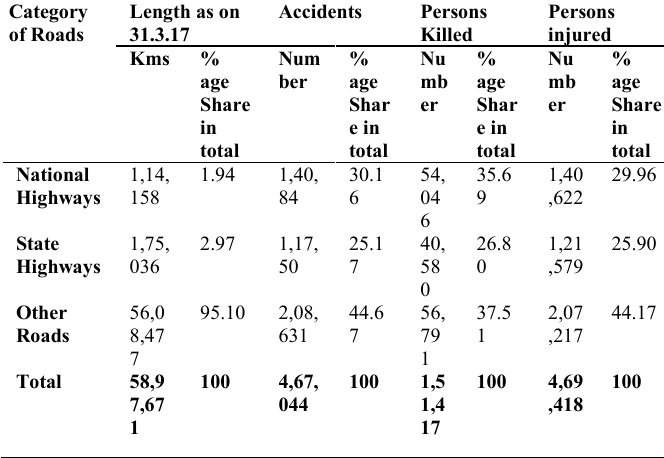
Table 1. Accident, Killed and Injured in 2018 [7]